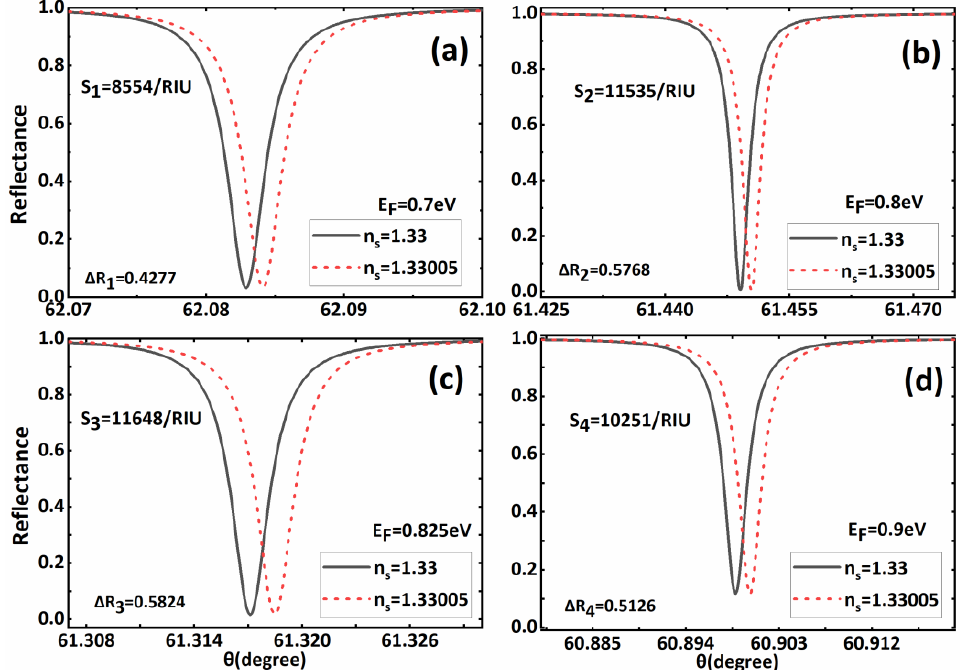
Figure 3. The reflection spectrum versus incident angle when n s = 1.33 and n s = 1.33005 respectively with ( a ) E F = 0. 7 eV , ( b ) E F = 0. 8 eV , ( c ) E F = 0. 825 eV and ( d ) E F = 0. 9 eV . The other parameters have the same values as those in Figure 2.